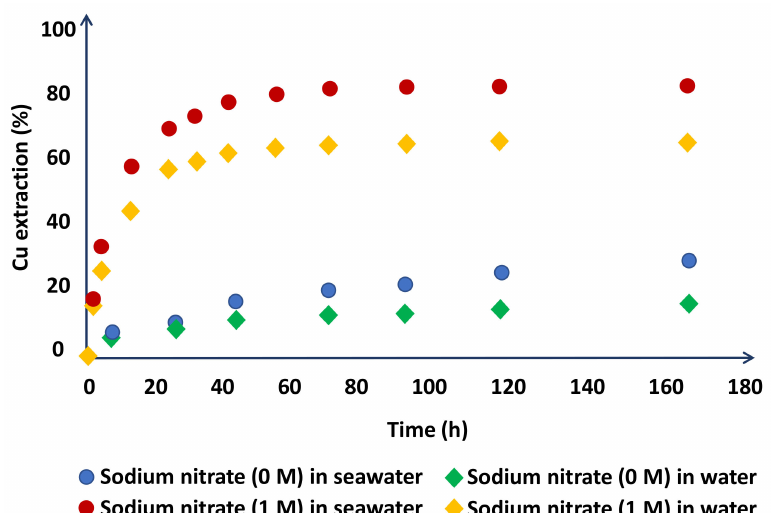
Figure 3. Chalcopyrite dissolution in the leach liquors using H 2 SO 4 (1 M) + NaNO 3 (0 or 1 M) in seawater- and water-based media (at 45 ◦ C) (Modified from: